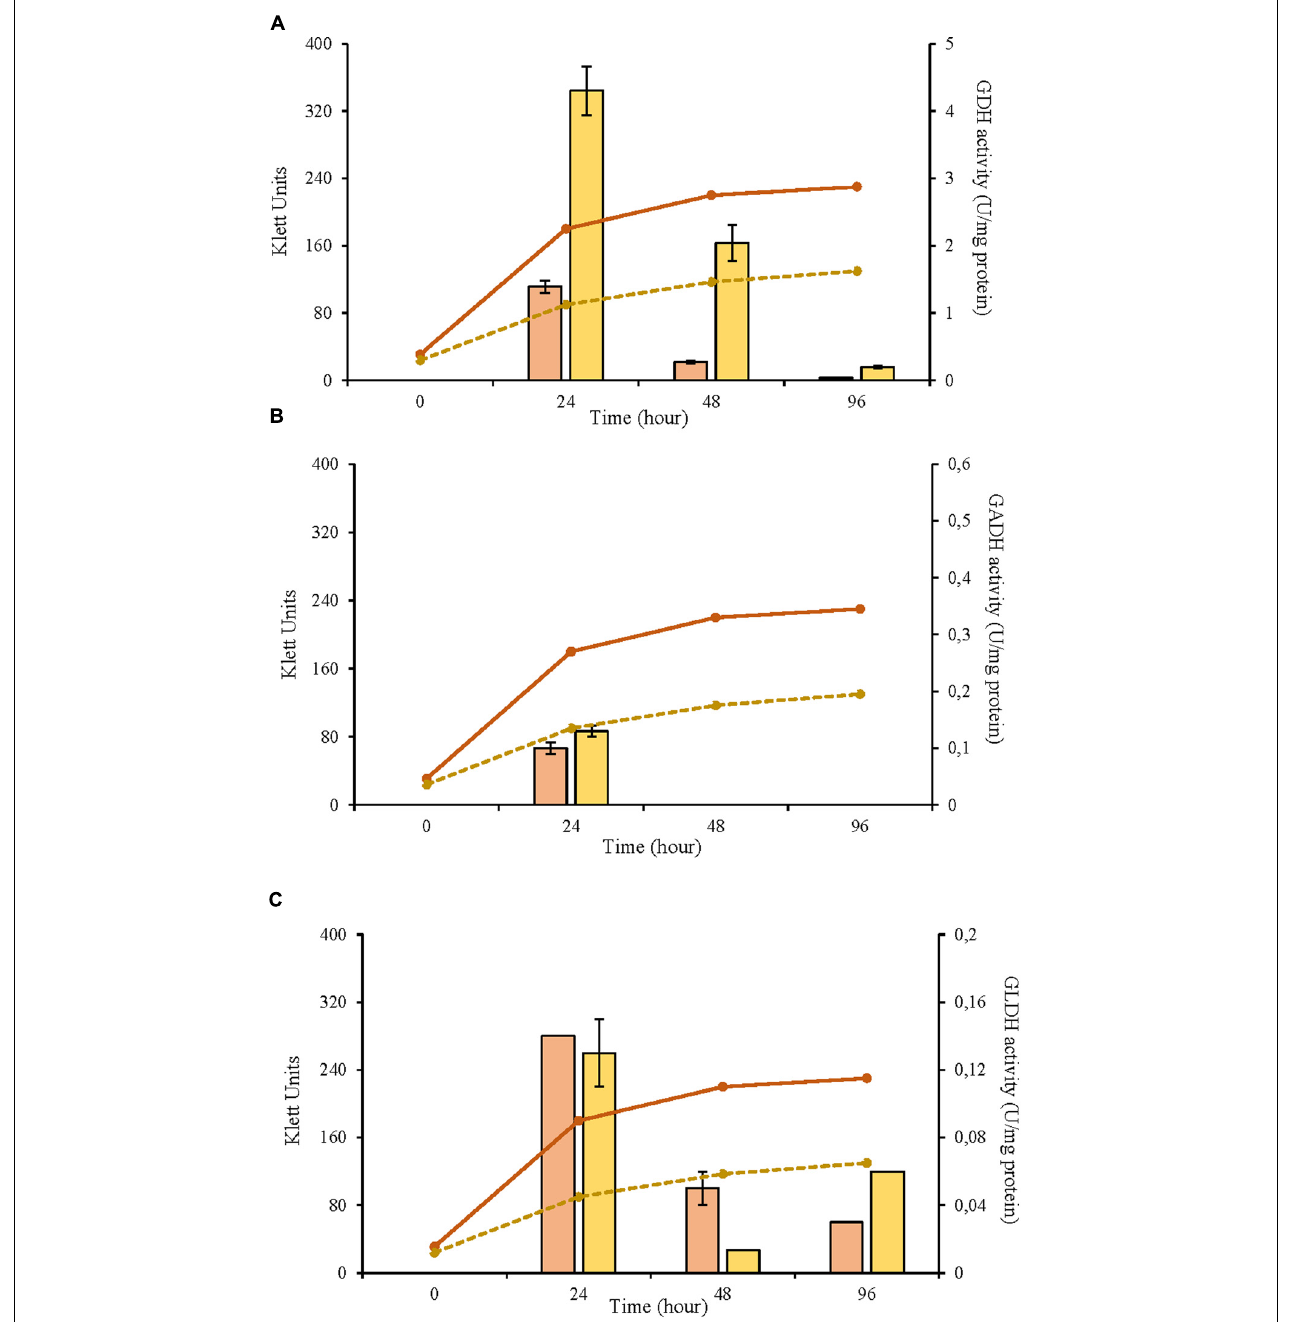
FIGURE 2 | Enzyme activity and growth (expressed in Klett units) of two Gluconobacter oxydans strains at three different growth stages (24, 48, and 96 h). (A) Glucose dehydrogenase activity (mGDH); (B) Gluconate dehydrogenase activity (GADH); (C) Glycerol dehydrogenase activity (GLDH); Enzyme activity represented in bars: 621H ( (cid:4) ), Po5 ( (cid:4) ) and cell growth with lines: 621H ( ); Po5 (